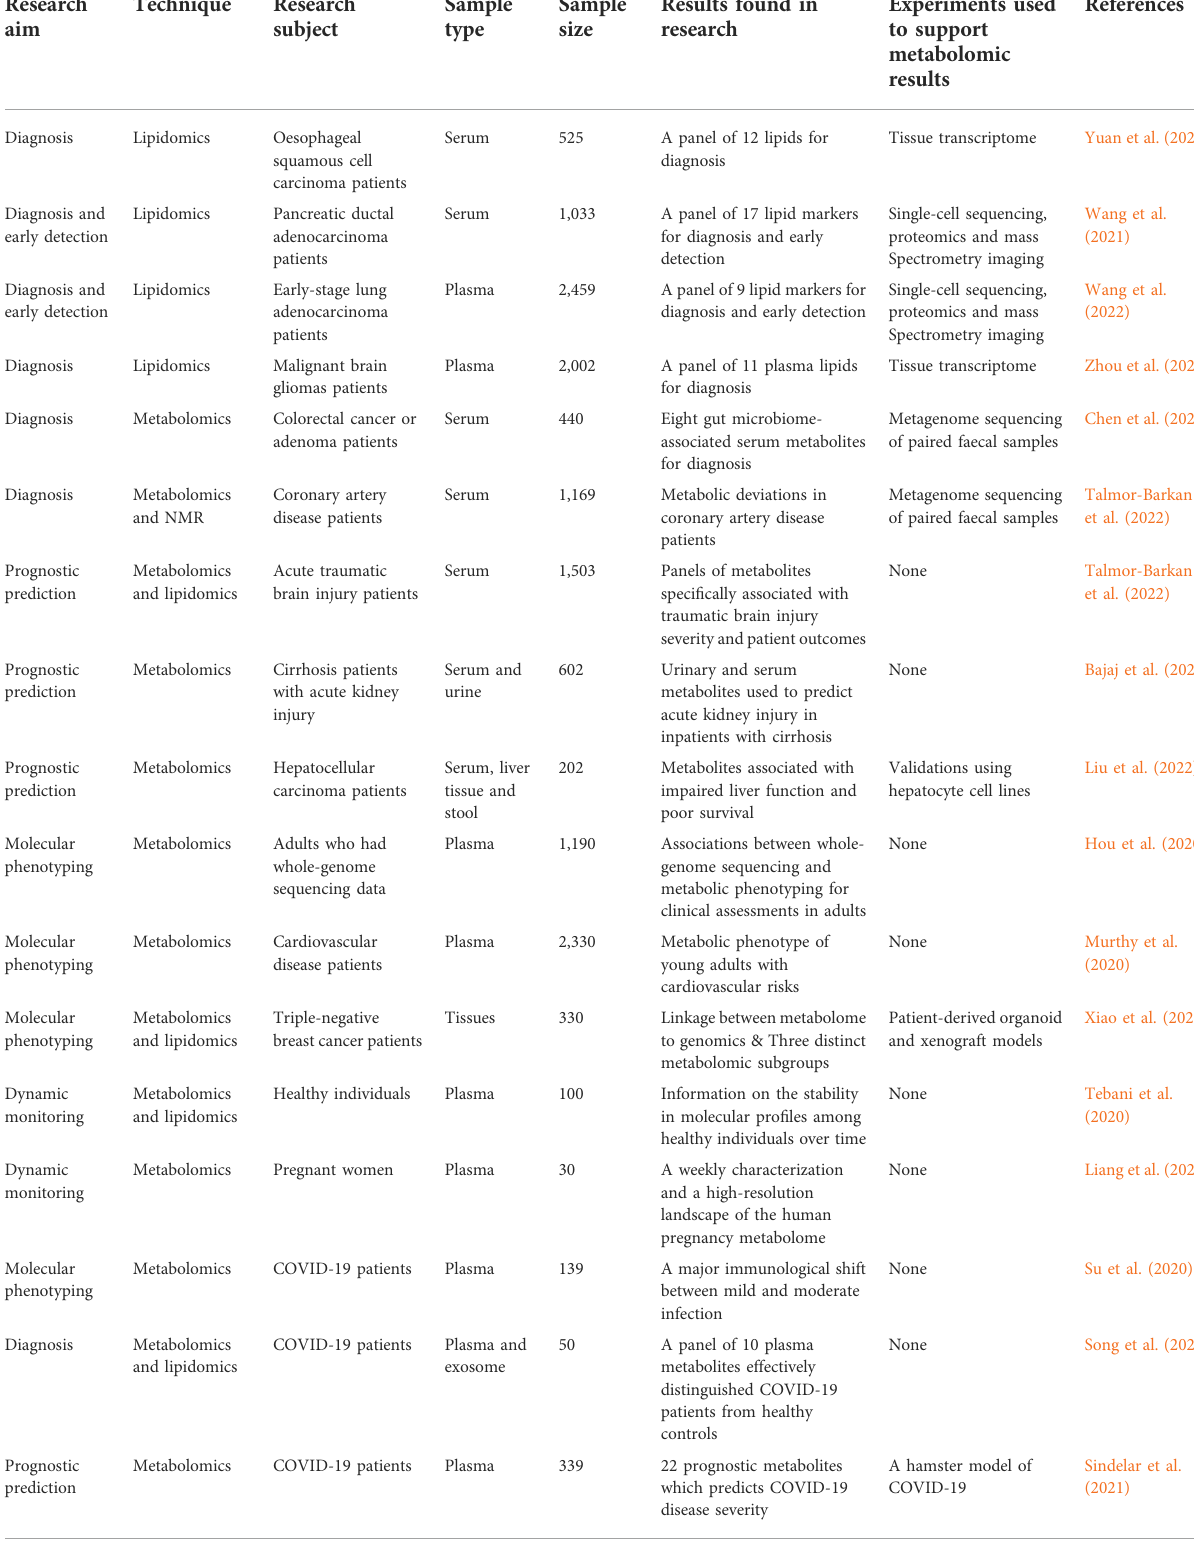
TABLE 1 Brief summary of LC-MS based metabolomic researches on precision